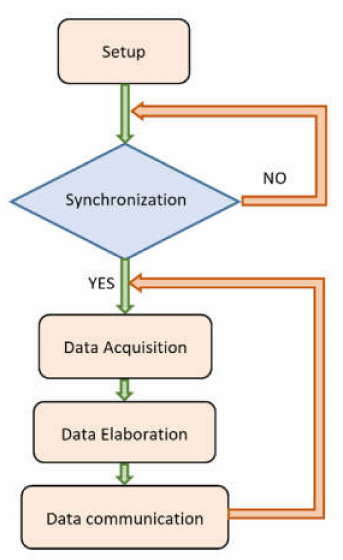
Figure 12. Block diagram of the firmware.